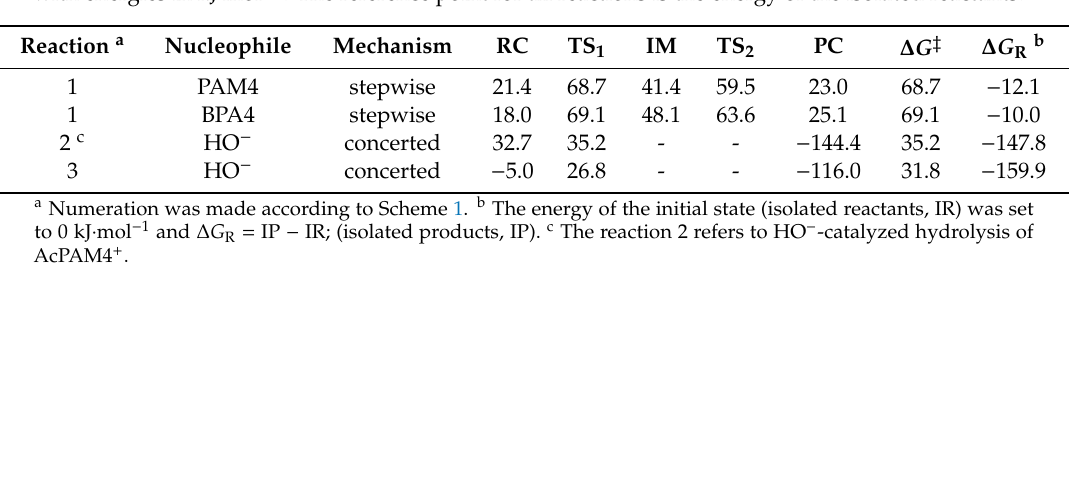
Table 2 and Figure 4. The key geometric parameters for the reactant complex (RC), transition state (TS), intermediate (IM) and product complex (PC) of the acetylation and deacetylation stages of AcSCh + hydrolysis are listed in Table S1.